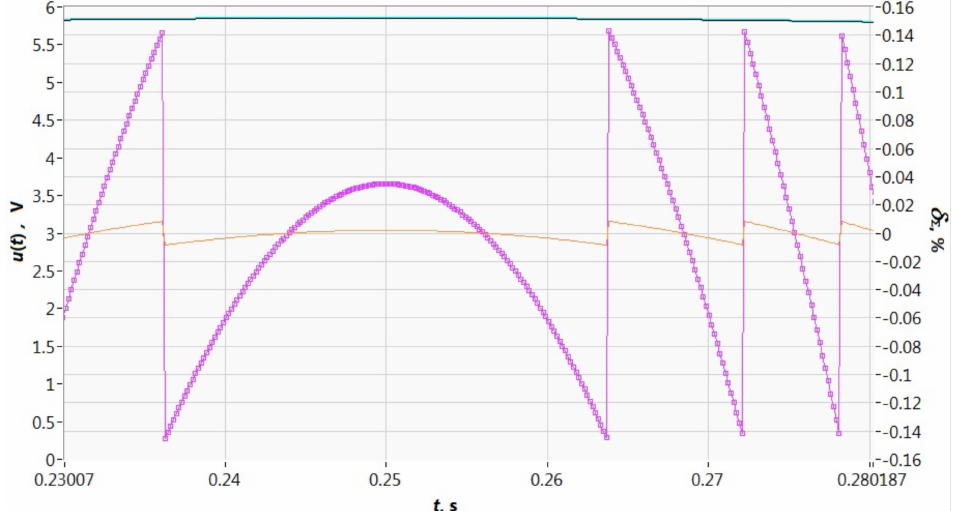
Figure 13. Presentation of the formation of the maximum value of the quantization error.